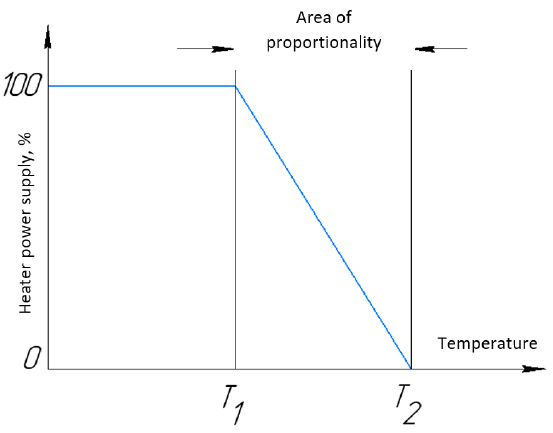
Figure 10. Transfer function of proportional control.